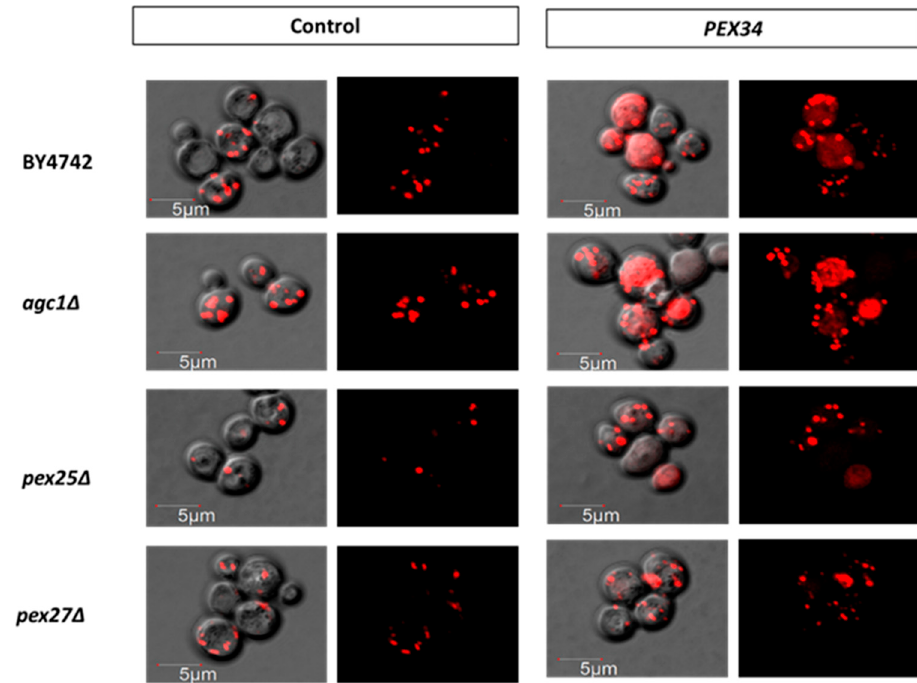
Figure 5. PEX34 -induced peroxisome proliferation requires PEX27 under a limited glucose condition. Yeasts lacking genes involved in peroxisome proliferation ( PEX25 , PEX27 ) containing peroxisome marker plasmid (RFP-PTS1) were tested for visualizing peroxisomes under PEX34 over-expression. Yeasts were grown in SD broth supplemented with 0.1% glucose until late log phase and then used for imaging peroxisomes with confocal fluorescence microscopy. The red-dot signal represented peroxisomes. Note that PEX34 over-expression induced the proliferation of tiny peroxisomes.